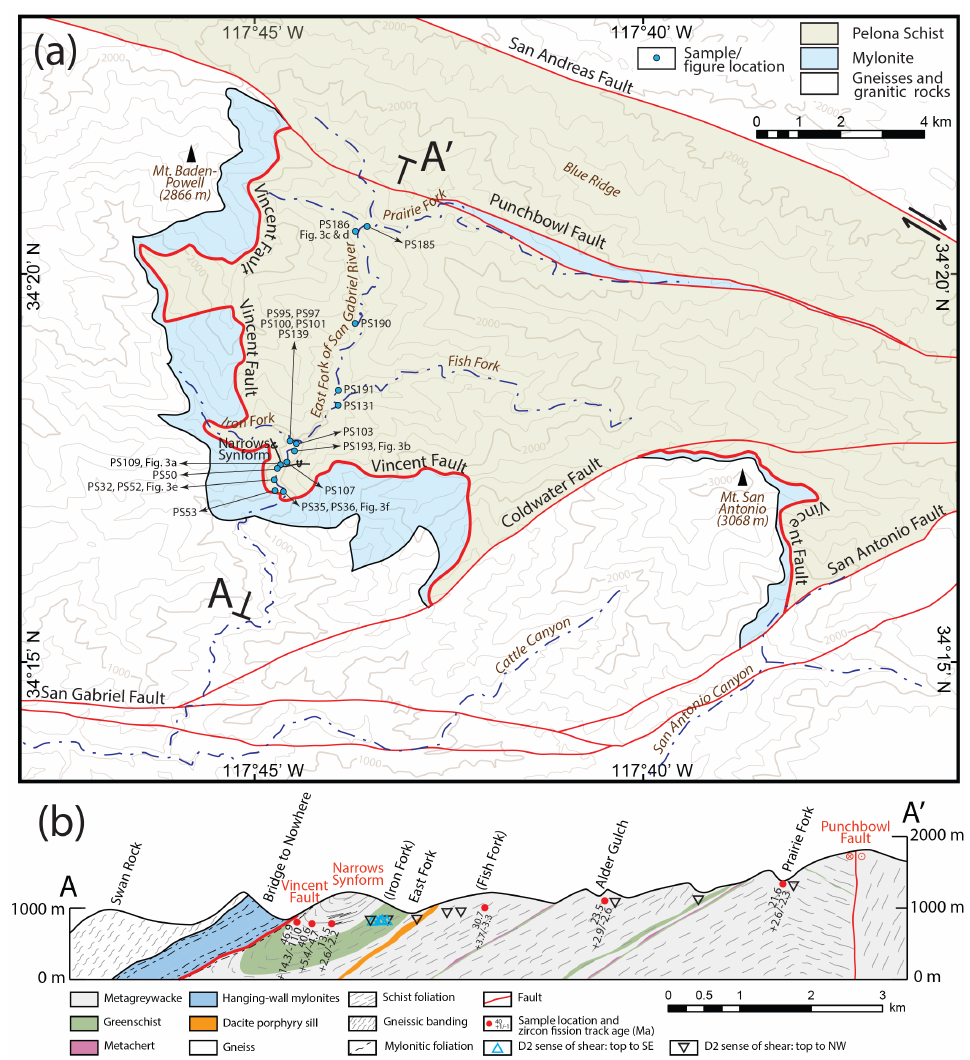
Figure 2. (a) Geologic map of eastern San Gabriel Mountains. Modified from Dibblee (2002a, b, c, d). The background topographic map is adapted from the 1:100000-scale Metric Topographic Map of San Bernardino, California, compiled and published by the United States Geological Survey in 1982. Contour interval of 200m. (b) Cross section of A-A (cid:48) in panel (a)